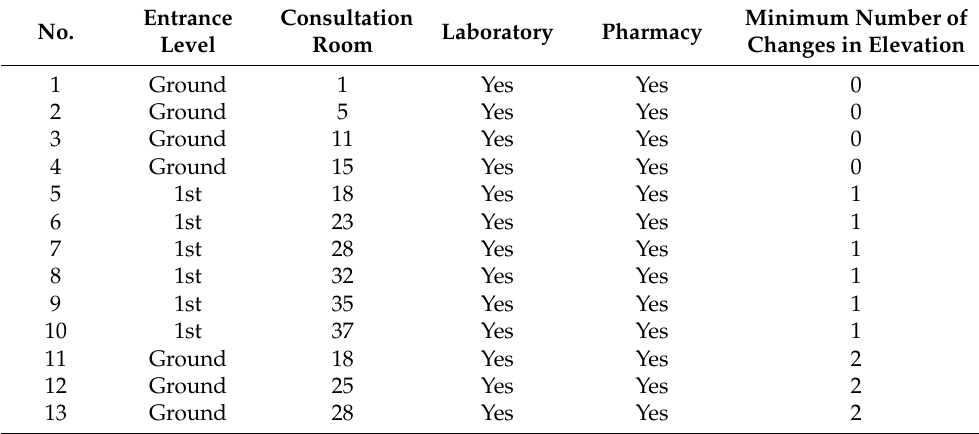
Table 1. Description of the paths selected for the